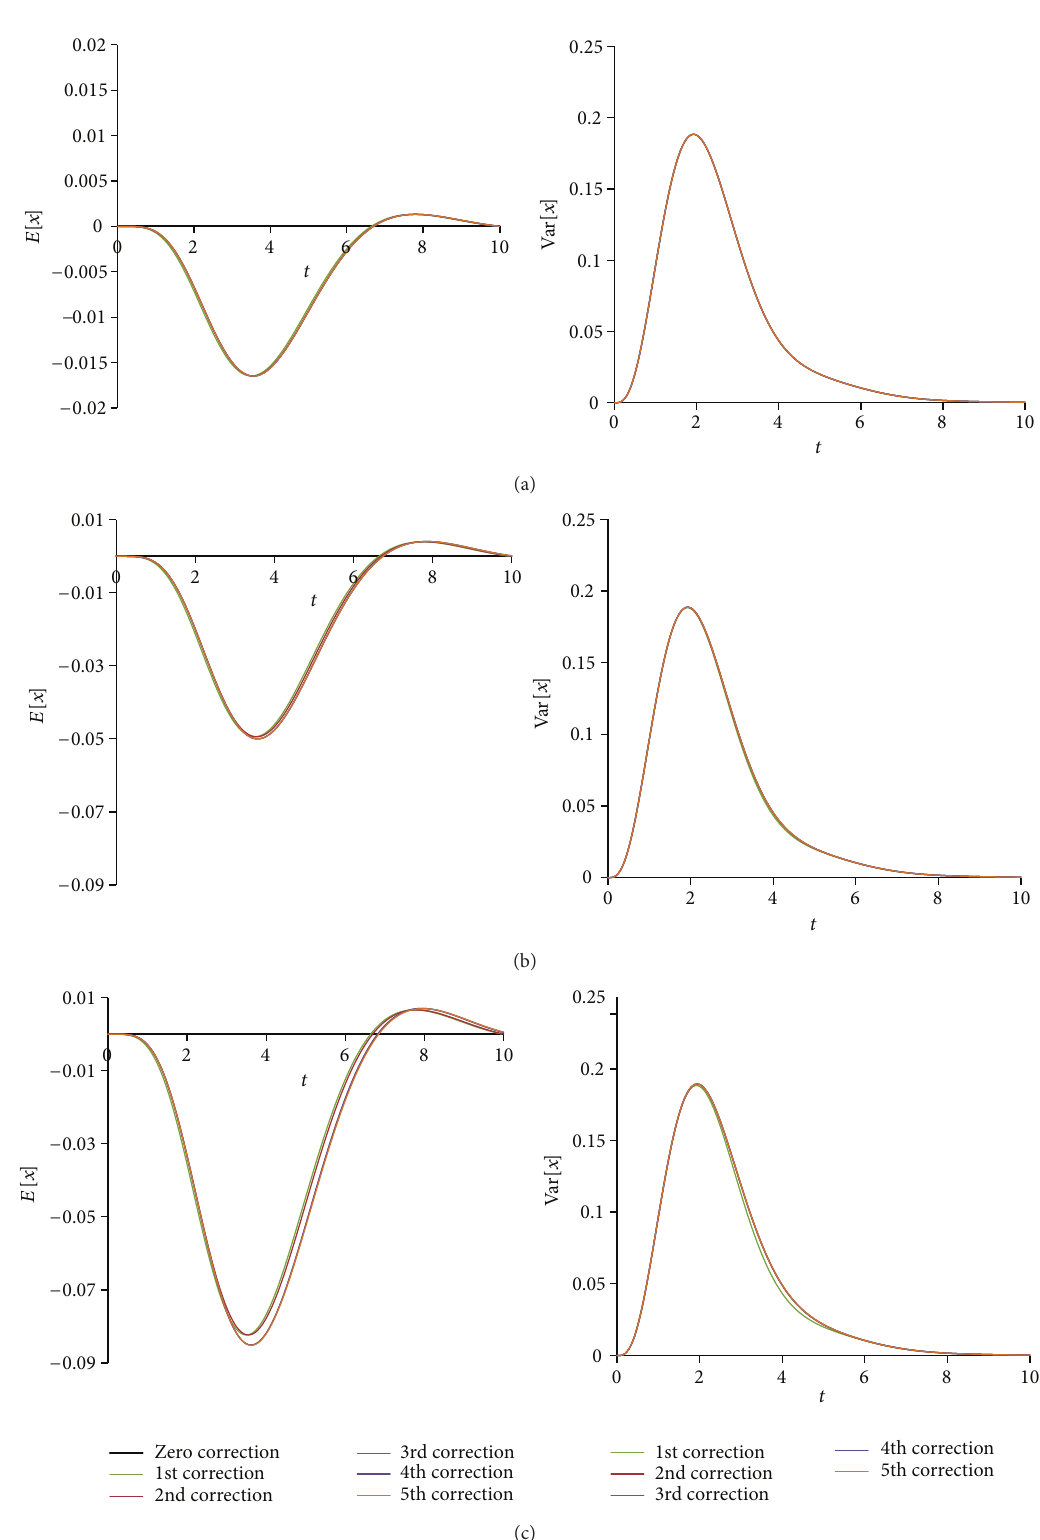
Figure 5: The first-order response mean and variance for (a) 𝜀 = 0.1 , (b) 𝜀 = 0.3 , and (c) 𝜀 = 0.5 . Case of exponential function 𝑒 −0.5𝑡 multiplied by the white